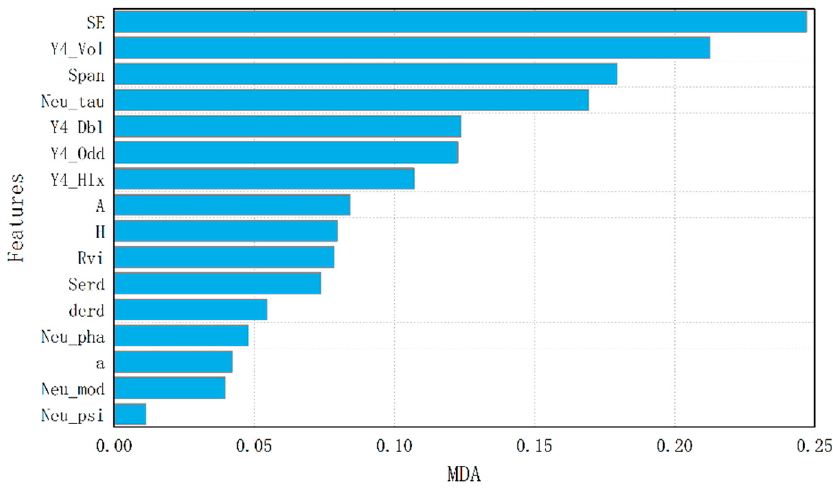
Figure 4. The importance of each polarization feature in wetland classification.